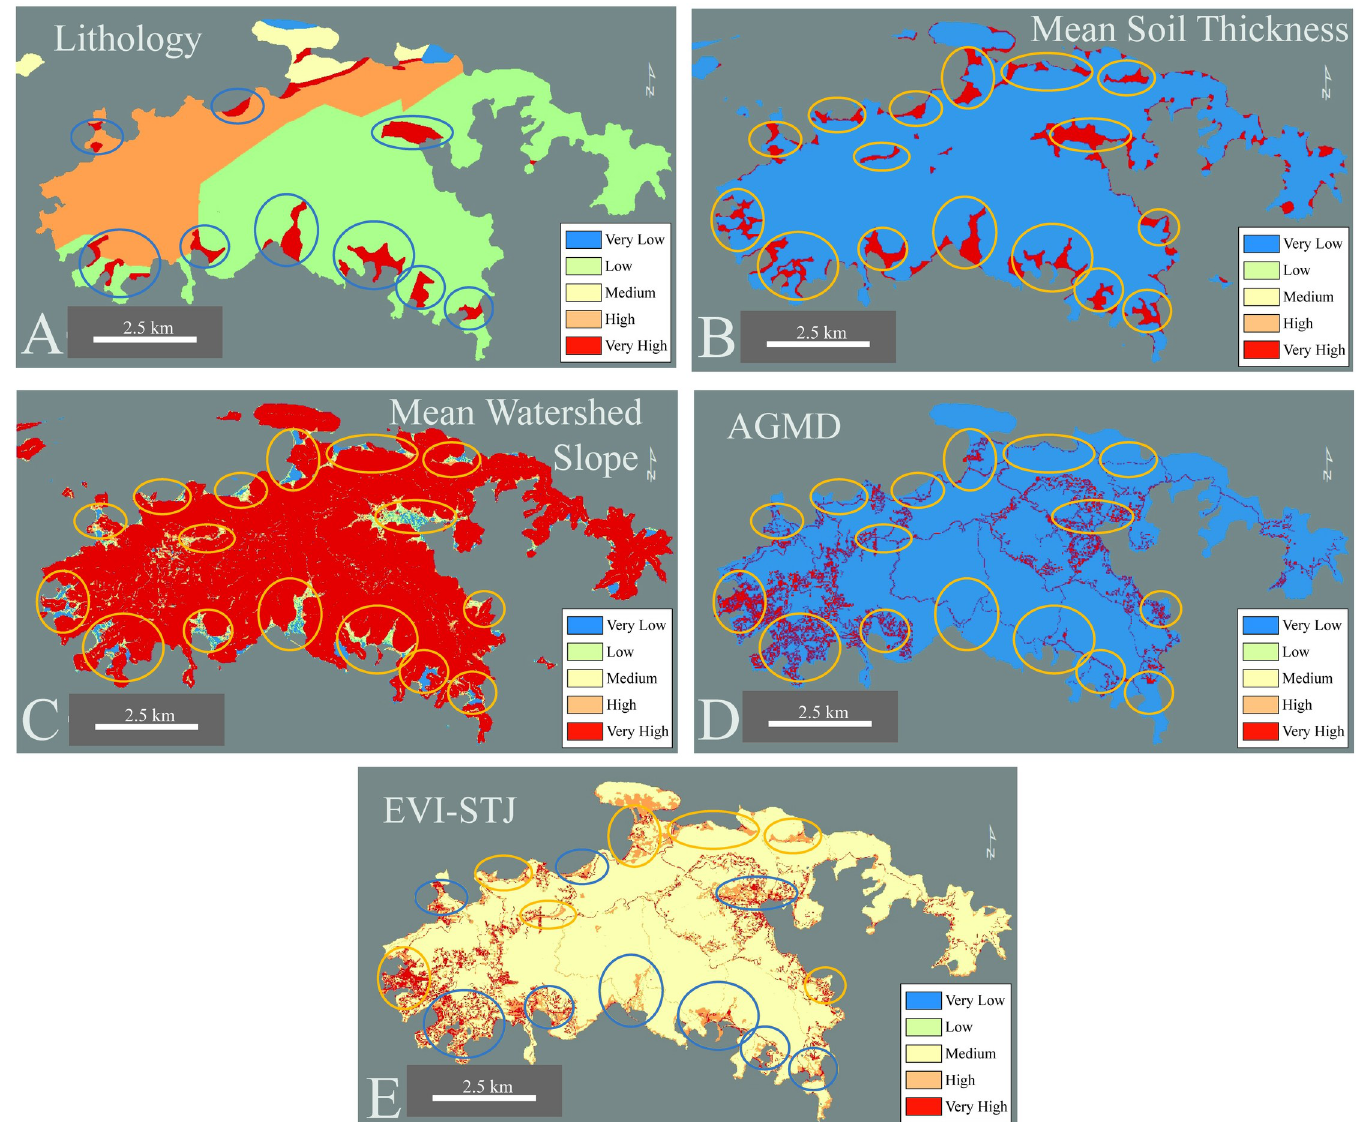
Fig 2. Comparison of Risk Factors for Lithology (A), Mean Soil Thickness (B), Mean Watershed Slope (C), AGMD (D), and the EVI-STJ (E). Very High Risk Factors for Lithology and Mean Soil Thickness Correlate with Low Risk Factors for Mean Watershed Slope. Low-lying areas or basins collect alluvium and greater soil thicknesses. Due to this, these areas have higher Risk Categories for the EVI-STJ. Much of the AGMD is concentrated in these areas. Lower slope areas are easier to build on and thicker soil mantles allow for easier construction. Thus, these circled regions (if currently lacking AGMD) could be regions that are targeted for development in the